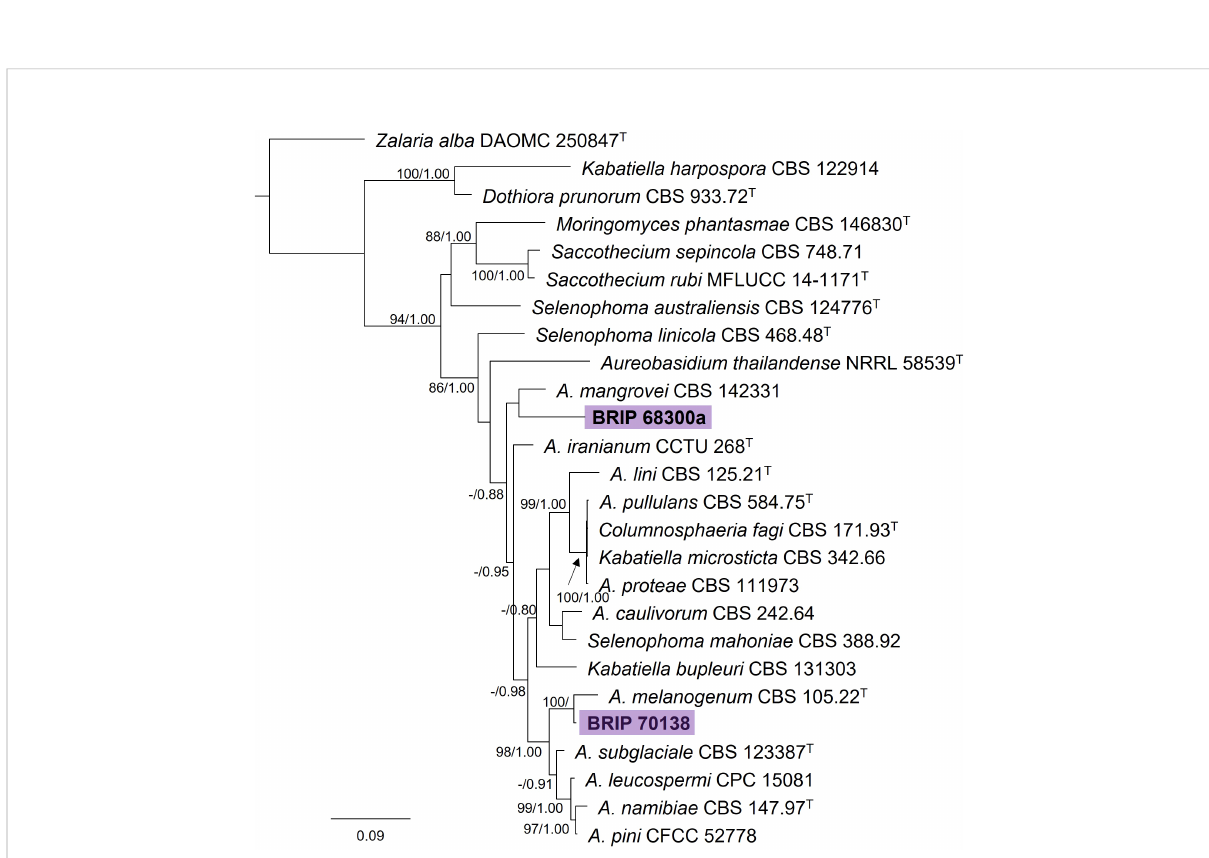
FIGURE 5 Phylogenetic tree inferred from a RAxML analysis based on a concatenated alignment of ITS, LSU, rpb2 and tub2 sequences of related genera in Saccotheciaceae (Dothideales). RAxML bootstrap (bs) values greater than 70% and Bayesian posterior probabilities (pp) greater than 0.8 are given at the nodes (bs/pp). In bold font are the isolates from this study, and ex-type strains are indicated by T .